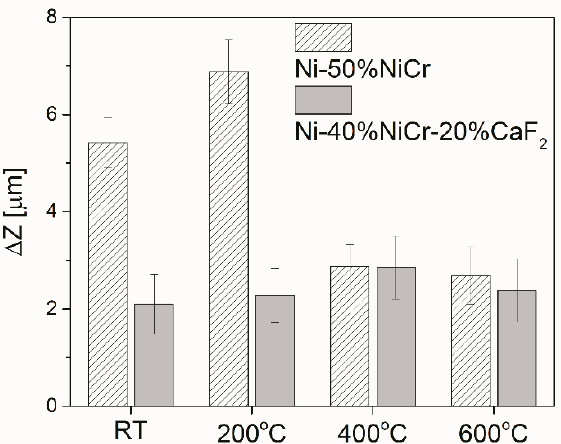
Figure 14. Level differences between the base material and wear track ( Δ Z) of the counter-specimens.